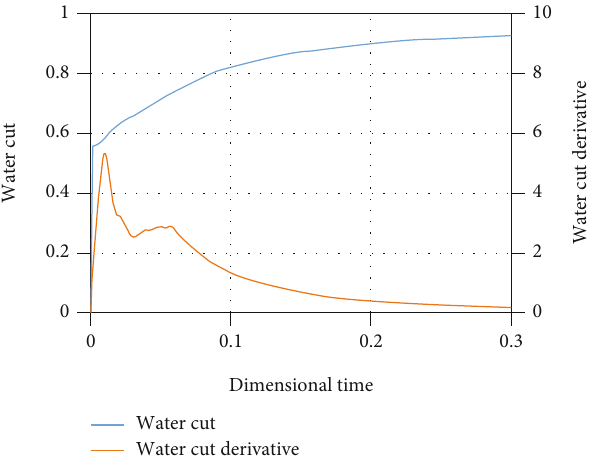
Figure 4: Fitting analysis of well test curves of typical wells.